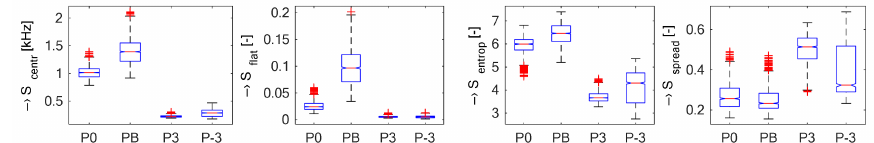
Figure 6. Box-plot of basic statistical parameters of supplementary spectral properties (centroid, flatness, entropy, spread) determined from the vibration signal picked up at different measuring positions {P0, PB, P3, P-3} during the SE sequence (TE = 18 ms, TR = 400